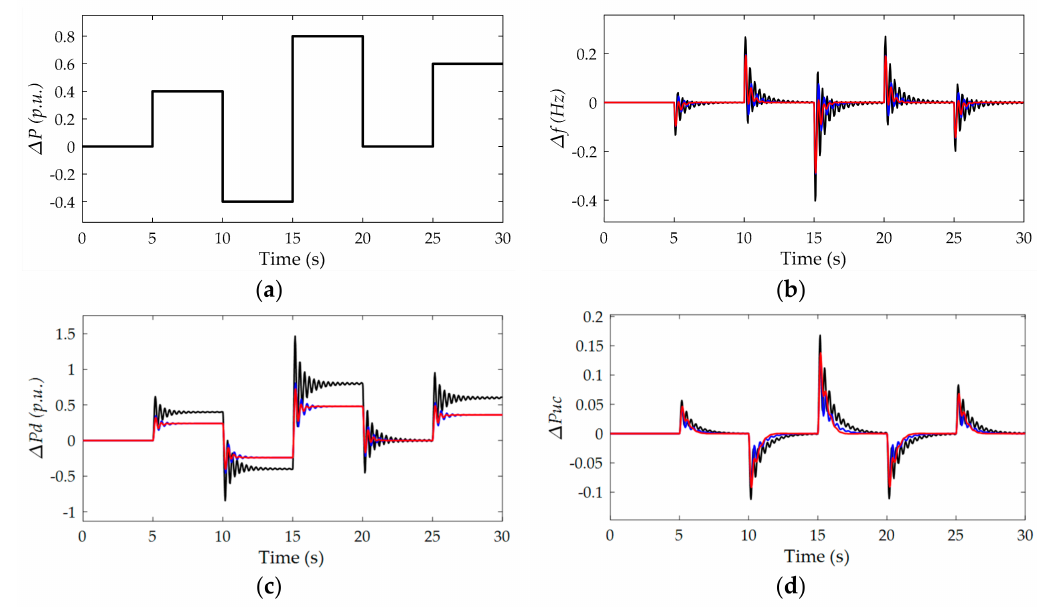
Figure 10. Outputs response with renewable energies power change by PID control (black), H ∞ control (blue) and µ -synthesis control (red), ( a ) renewable energies power change; ( b ) frequency deviation; ( c ) diesel engine power deviation; ( d ) ultra-capacitor power deviation.